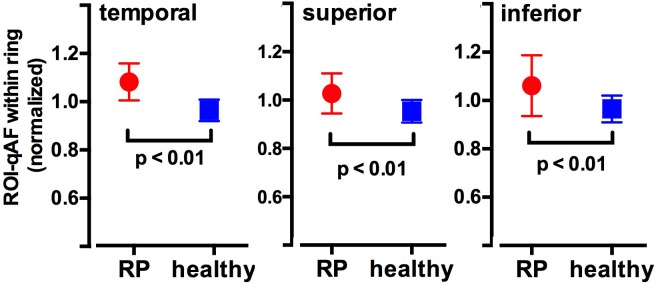
Region of interest-qAF within the ring normalized to ROI-qAF immediately external to the ring. Region of interest-qAF in healthy eyes was determined at equivalent locations. Region of interest-qAF measurements were acquired at temporal, inferior, and superior locations on the ring. Mean ± SD. P values determined by unpaired t-test.